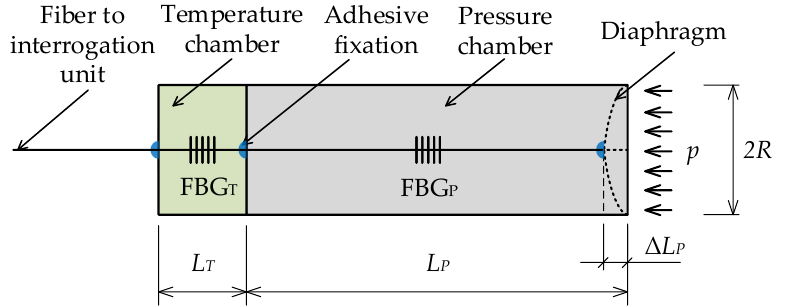
Figure 3. Construction of a pressure membrane of the FBG pressure sensor with temperature compensation FBG T